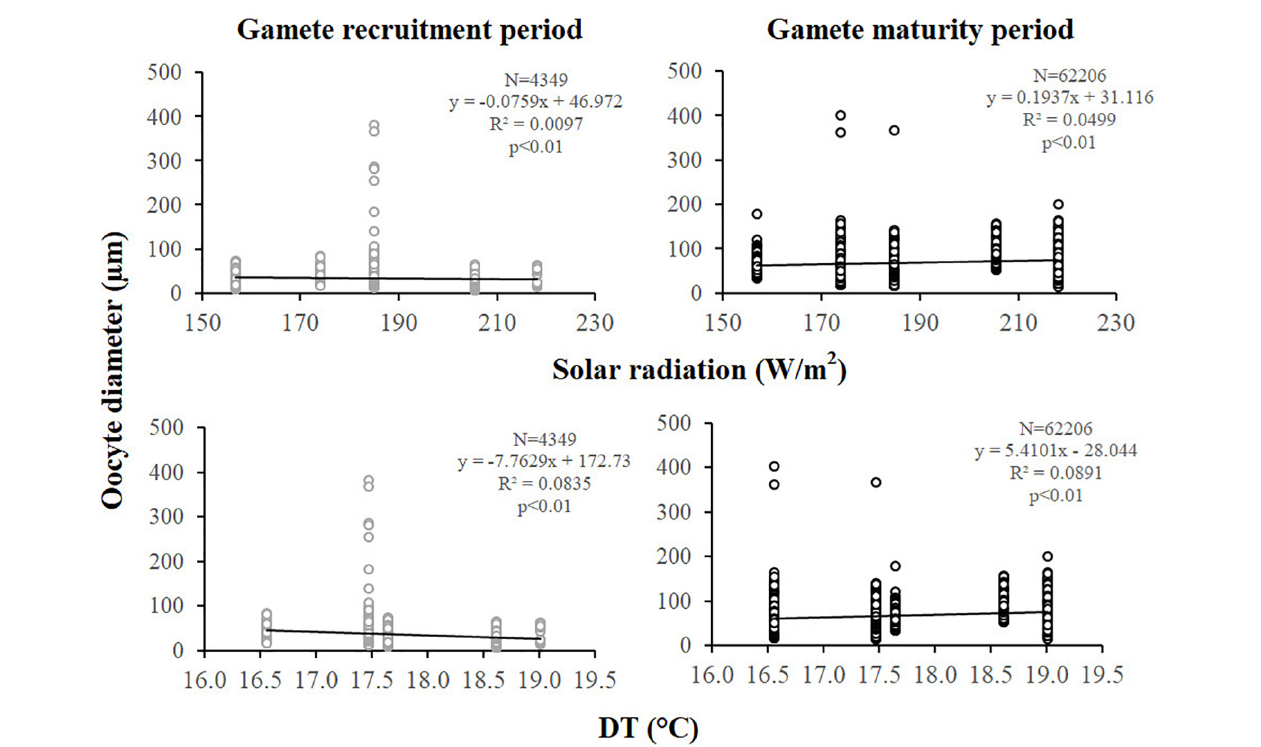
FIGURE 5 | Oocytes. Correlation analysis between oocyte diameter and environmental parameters for gamete recruitment and maturity periods. N , oocyte number; R 2 , coefficient of determination; p , significance of p